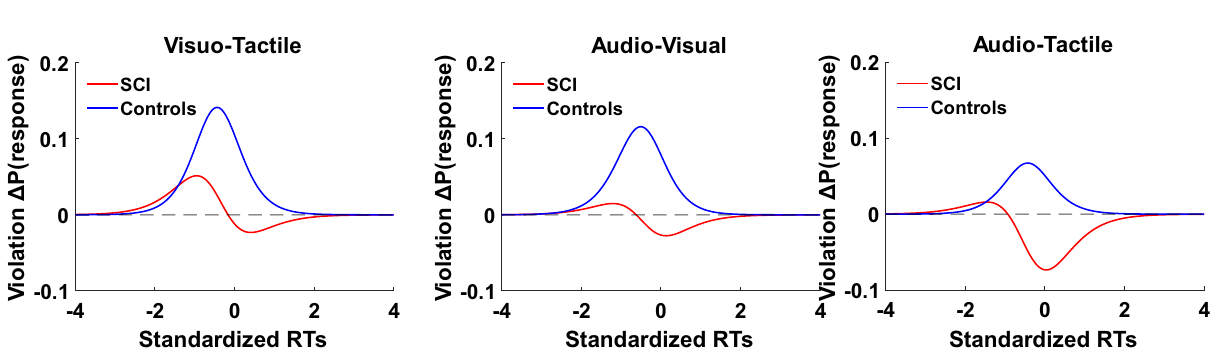
Figure 5. Race model violations (for the entire RT distribution): Figure shows violations in each condition for each group (red lines represent SCI participants, blue lines healthy controls) measured as the difference (Δ) in the CDFs between bimodal and the correspondent race (known as Miller’s Inequality). Positive values (above 0) denote the multisensory enhancement effect. Standardized RTs indicate